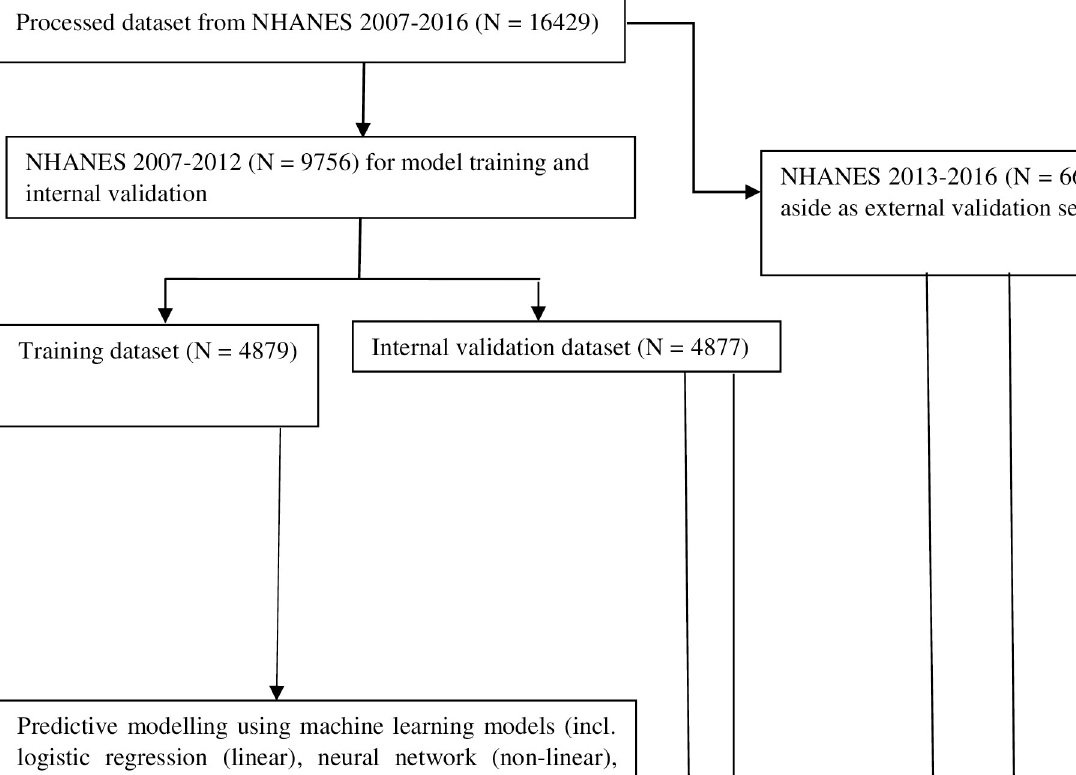
Fig 1. Flowchart depicting the analytic workflow adopted in the study. a-adjusted by resampling methods incl. oversampling, under-sampling, random oversampling (ROSE) and synthetic minority oversampling technique (SMOTE).